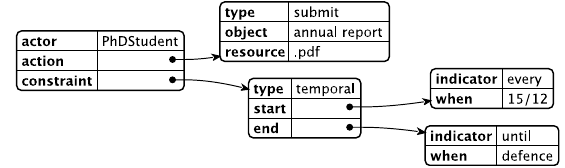
Figure 2: “Annual progress evaluation” represented through the generic rule